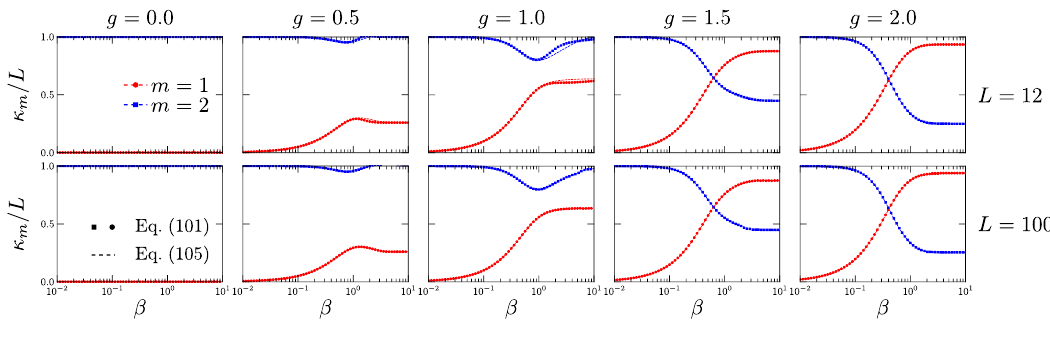
Figure 9: Cumulants of the magnetization distribution as a function of the in- verse of temperature β . Using the full characteristic function given by Eq. (101), the mean value of the transversal magnetization κ and the variance κ are shown 1 2 by red circles and blue squares, respectively. The dashed lines correspond to the numerical results using the simplified characteristic function (Eq. (105)). In the fer- romagnetic phase the statistics is super-Poissonian, while it changes from super- to sub-Poissonian in the paramagnetic phase as the temperature is decreased. The mag- netic field varies from 0.0 to 2.0 from left to right in steps of 0.5. The system size is L = 12 in the upper row and L = 100 in the lower